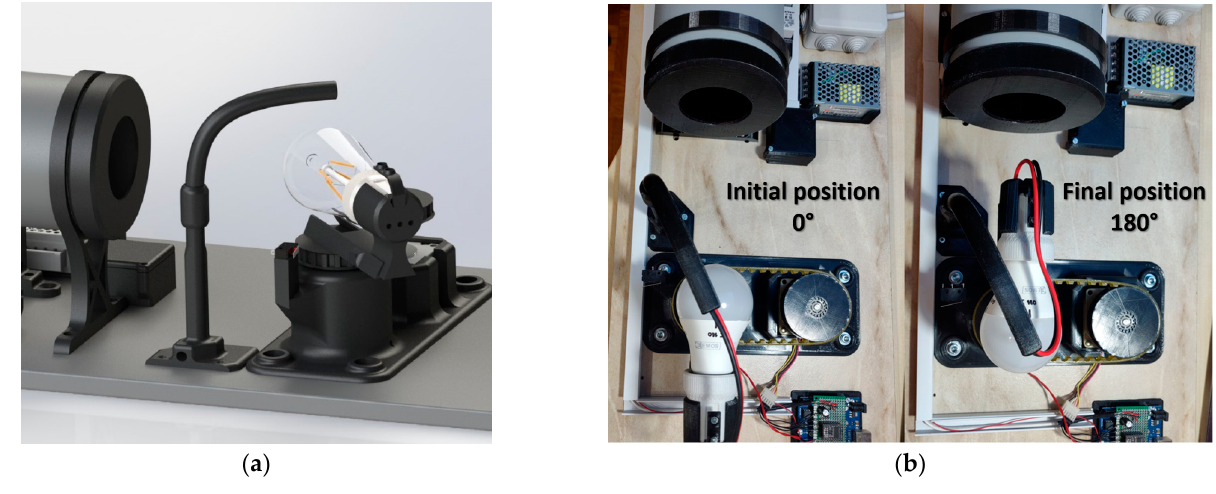
Figure 6. ( a ) Light bulb power cable stand; ( b ) The initial and final positions of the light bulb for plotting the polar diagram of the angular distribution of luminous intensity.